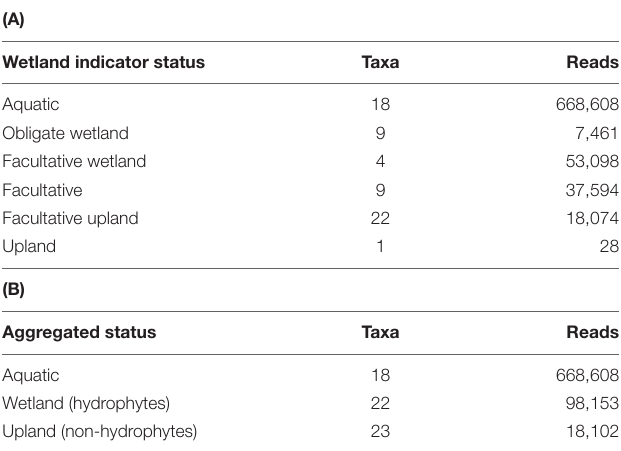
TABLE 2 | Taxon and read abundances of vascular plants by wetland status.